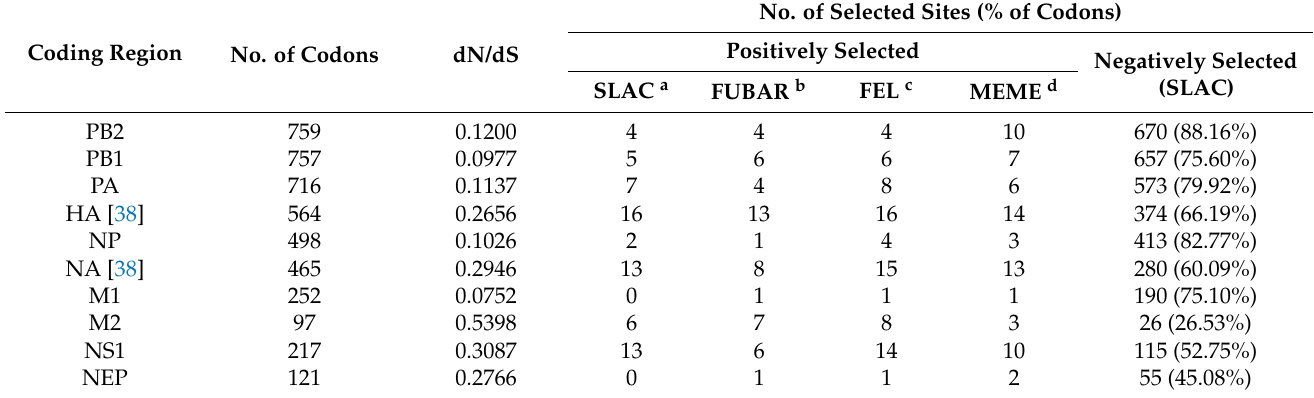
Table 1. Selection pressures and positively and negatively selected codons of coding regions of H7N9 viruses circulating between 2013 and